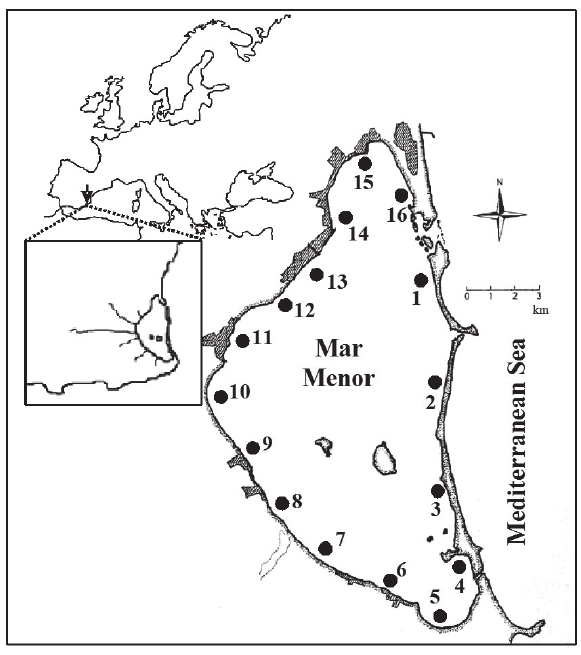
Fig . 1. − Geographical location of the Mar Menor coastal lagoon and location of sampling sites in the shallow littoral